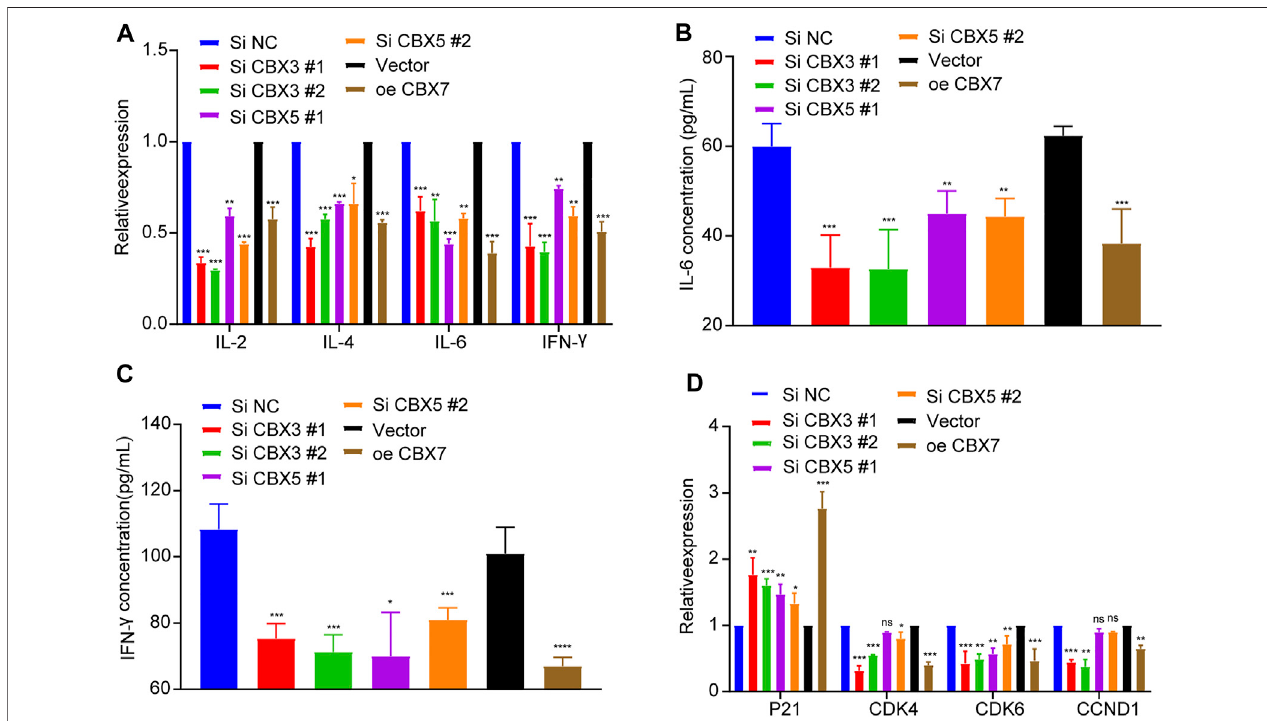
FIGURE9| CBX3/5/7regulatestheimmunemicroenvironmentandcellcycletransitioninLUAD. (A) Cytokineexpressionand (BandC) cytokinesecretionlevelsin LUAD cells. (D) Cell cycle transition related molecules expression levels in LUAD cells. NC: negative control. NS (cid:1) Not Statistically Signi fi cant. * p < 0.05, ** p < 0.01, and *** p <